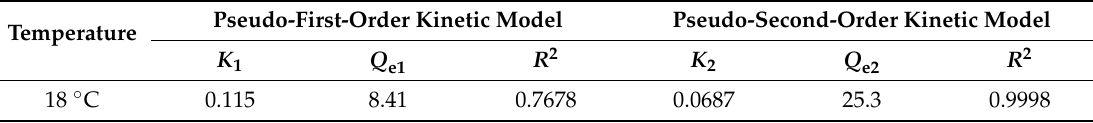
Table 4. Dynamic parameters of lithium adsorption. Figure 10. Pseudo-first-order and pseudo-second-order kinetic curves Li + adsorption by HMO at 18 °C.